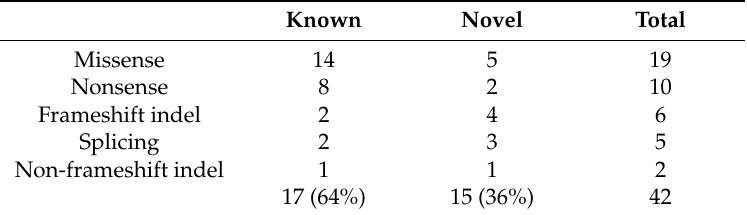
Table 1. Composition of pathogenic variants identified in the 30 Brazilian probands.